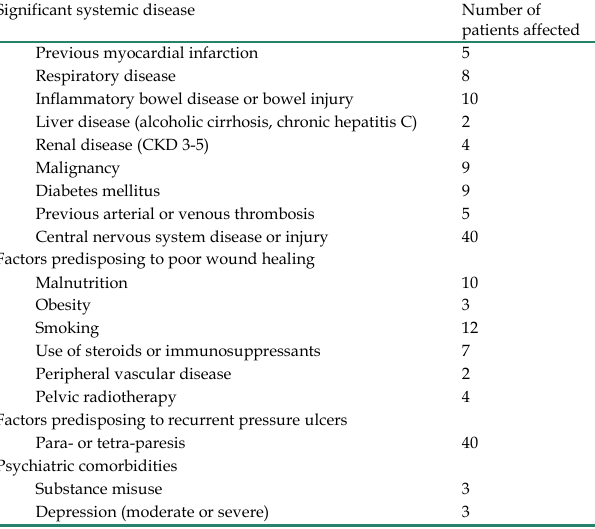
Table 1. Risk factors for pelvic osteomyelitis Significant systemic